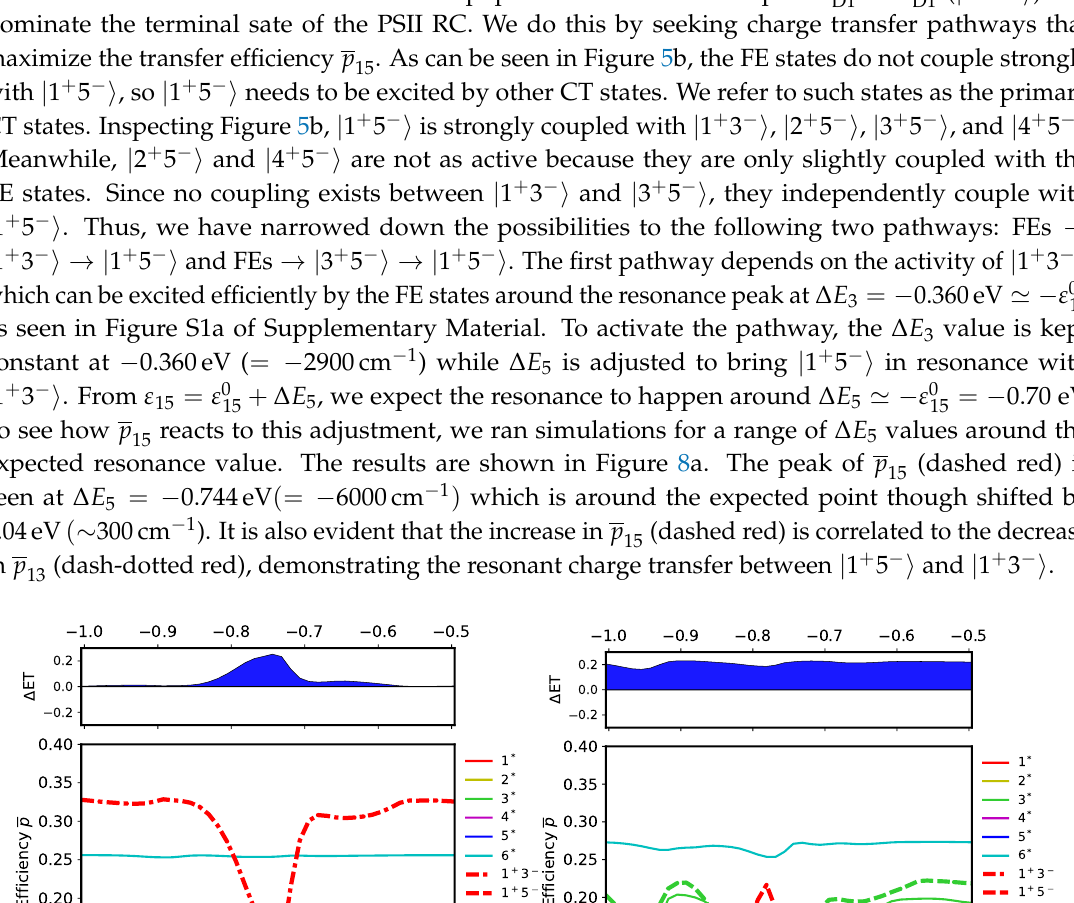
∆ E = ∆ E + 3400cm − 1 5 varied while 3 5